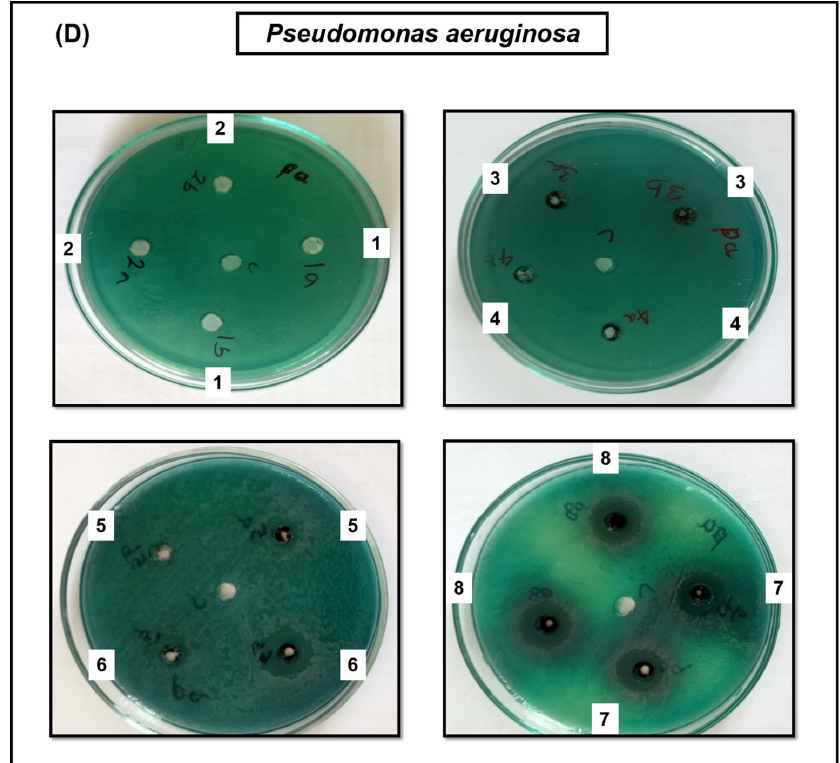
Figure 6. Antimicrobial activity of bulk g -C 3 N 4 (1), exfoliated g -C 3 N 4 (2), CuO (3), and different weight percentages of CuO loaded g -C 3 N 4 nanocomposite, 30wt% (4), 40wt% (5), 50wt% (6), 60wt% (7), and 70wt% (8) against Staphylococcus aureus ( A ), Streptococcus pyogenes ( B ), Escherichia coli ( C ), and Pseudomonas aeruginosa ( D ).